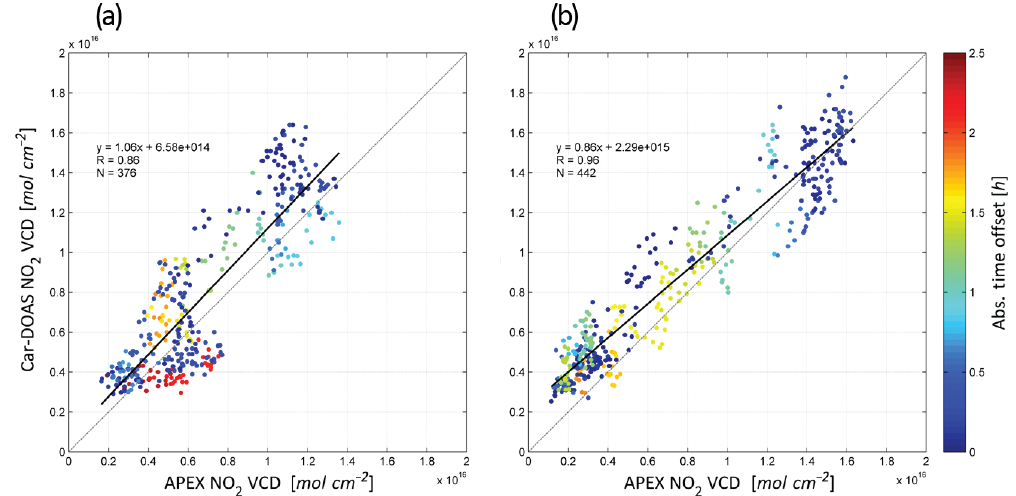
Figure 15. Scatter plots and linear regression analyses of the co-located NO 2 VCDs, retrieved from APEX and car DOAS for (a) the morning and (b) afternoon flights on 21 April 2016, respectively. Data points are colour-coded based on the absolute time offset between APEX and car DOAS